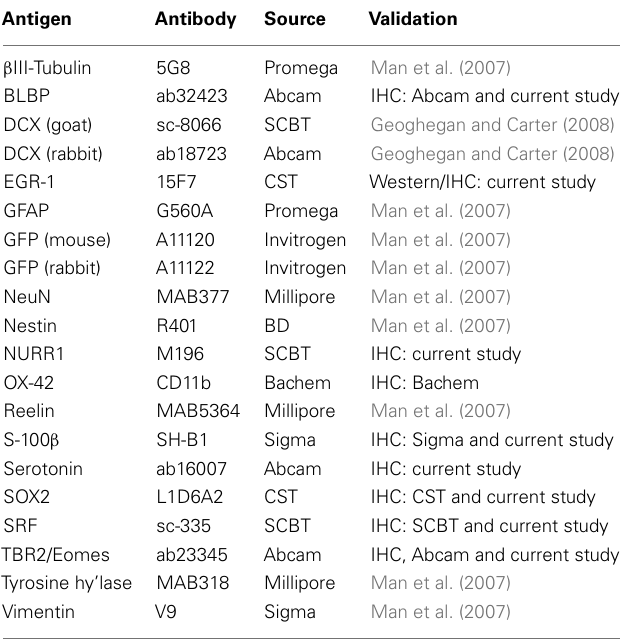
Table 1 | Source and validation of primary antibodies used in this